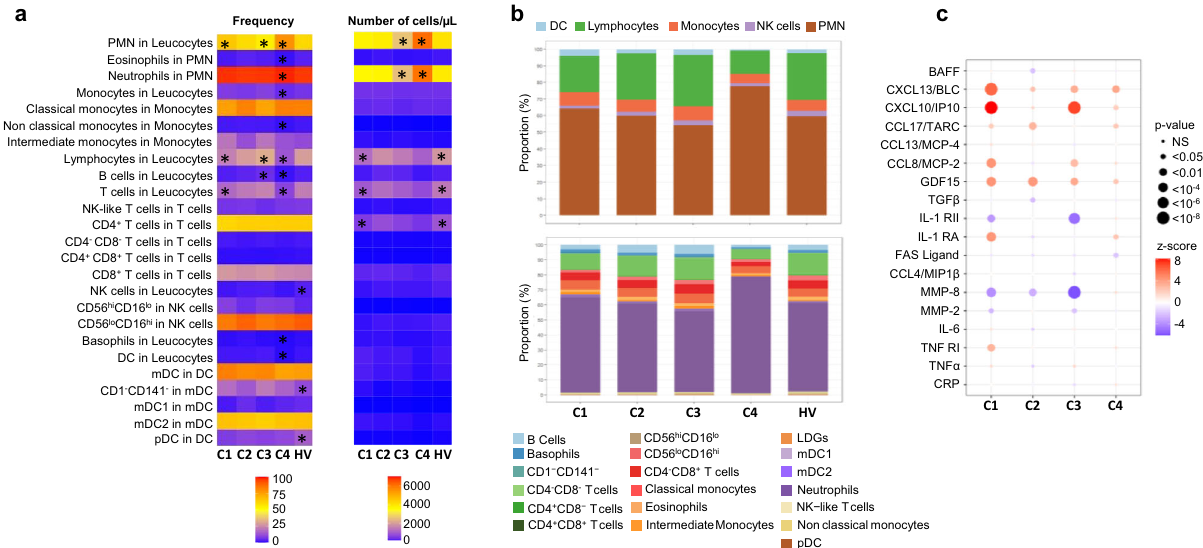
Fig. 6 Cell subset distribution in blood and cytokines, chemokines and in fl ammatory mediators in serum in the 4 clusters and healthy volunteers (HV). a Flow cytometry analysis was performed for 283 patients (C1: 96, C2: 71, C3: 80, and C4: 36) and 309 HV. The 2 heatmaps show the mean distribution of blood cell subsets in frequency (0 – 100%) and in absolute numbers (per µ L of blood) across the 4 clusters and HV assessed by fl ow cytometry. Columns represent clusters and HV and rows the different cell subsets. The asterisk means that the cluster (or HV) is statistically different from all the others. b Flow cytometry data represented by bar charts cell types proportion per cluster. c Serum mediators were analyzed for 192 pSS patients (C1: 67,